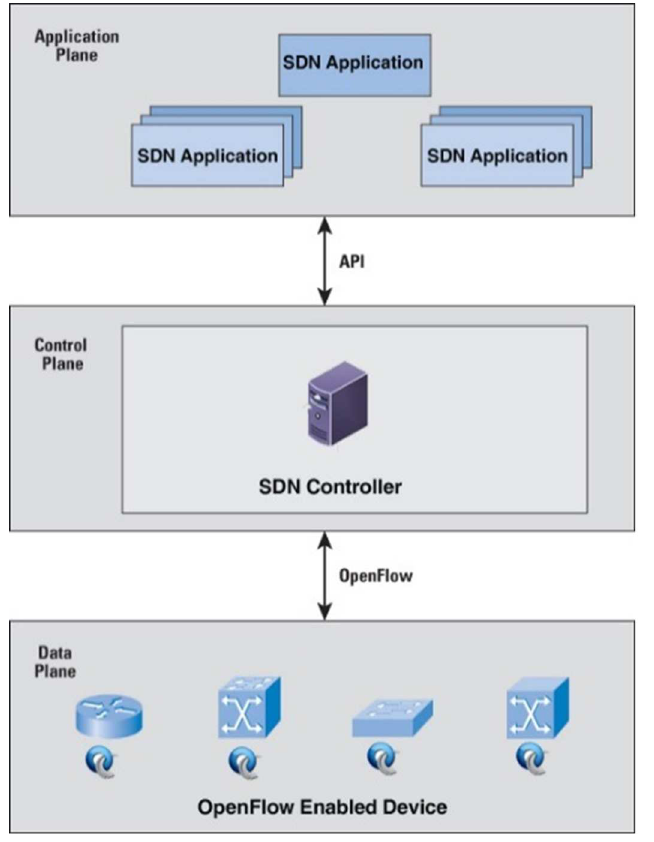
Fig 1. Software defined network